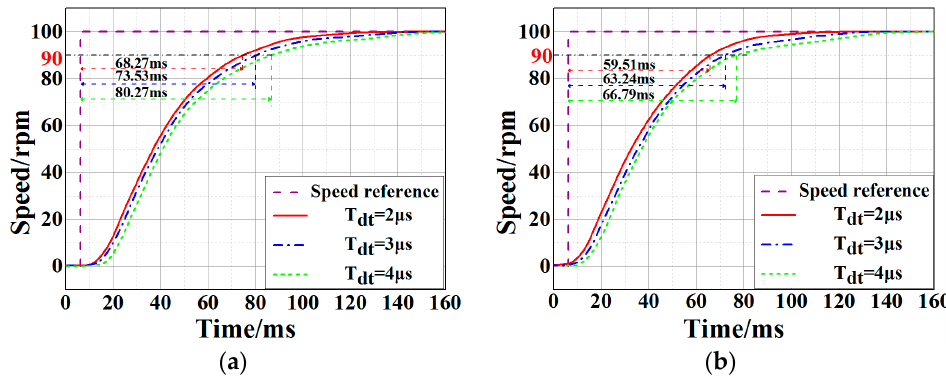
Figure 12. Step response of speed loop at 15 kHz with different dead time; ( a ) Si IGBT based system; ( b ) SiC MOSFET based system.